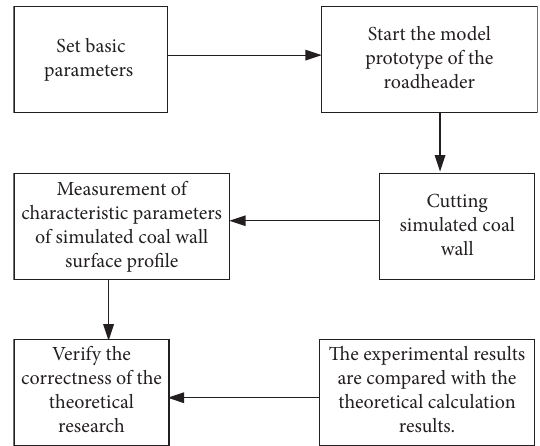
Figure 15: The experimental process.